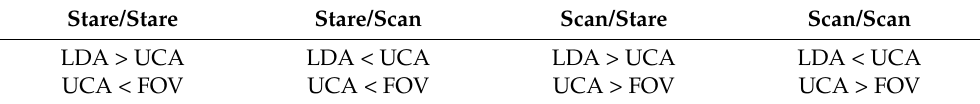
Table 2. The relationship among LDA, UCA and FOV for the four acquisition modes. Stare/Stare Stare/Scan Scan/Stare